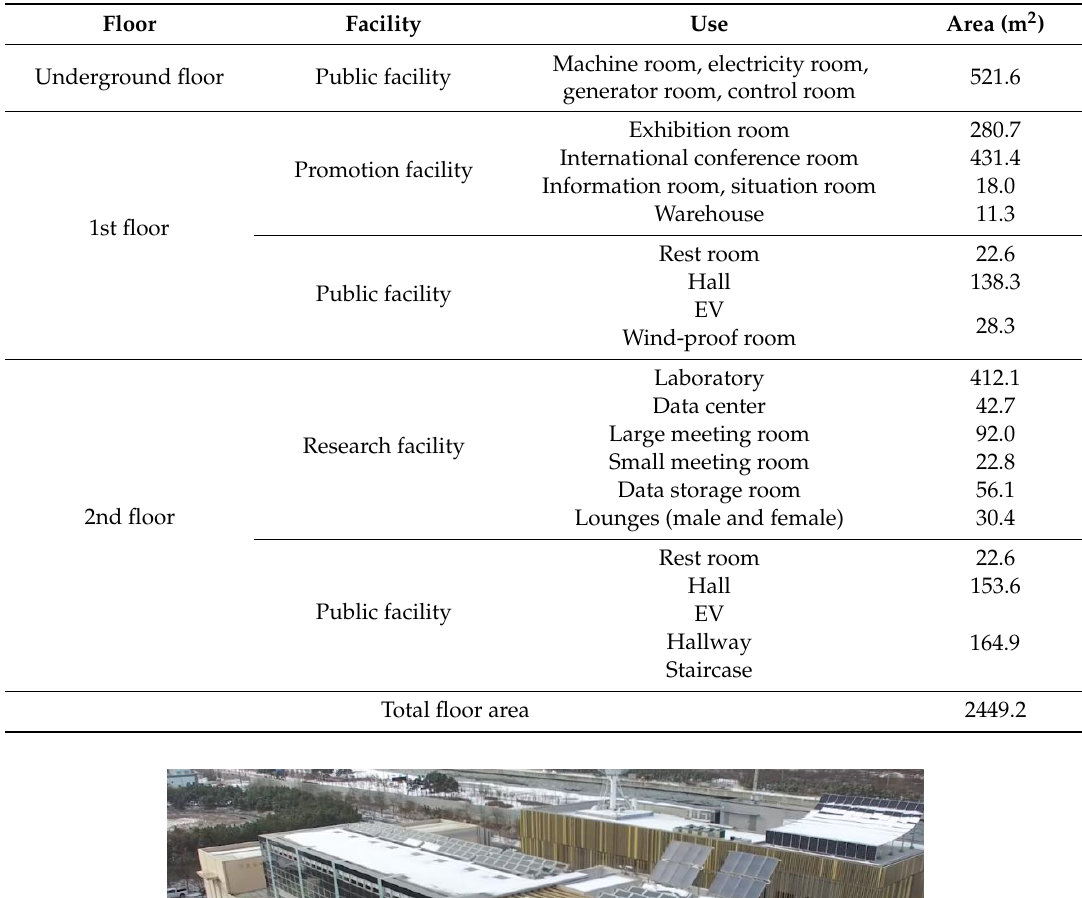
Table 1. Construction overview of the Carbon Zero Building.